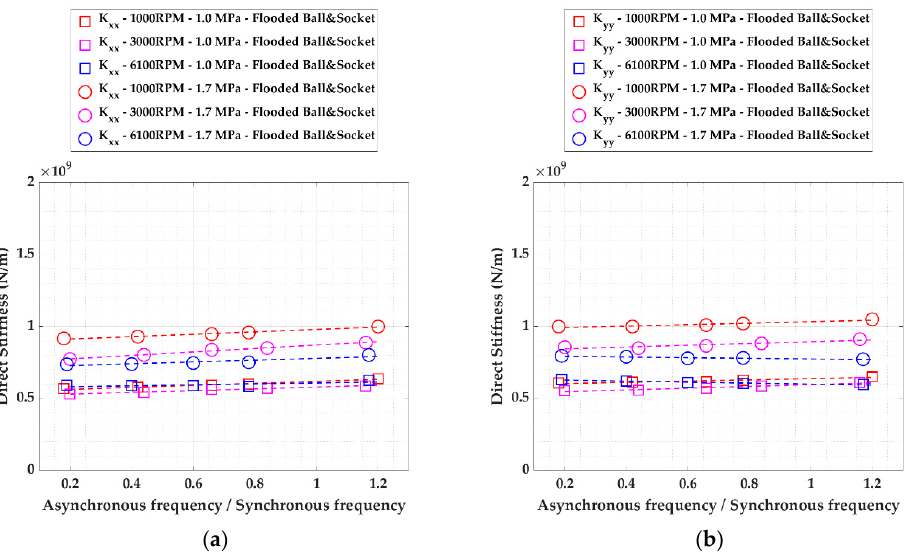
Figure A2. Flooded Ball & Socket Pivot bearing asynchronous direct stiffness coefficients at various speeds for 1.0 MPa and 1.7 MPa: ( a ) K xx , ( b ) K yy .